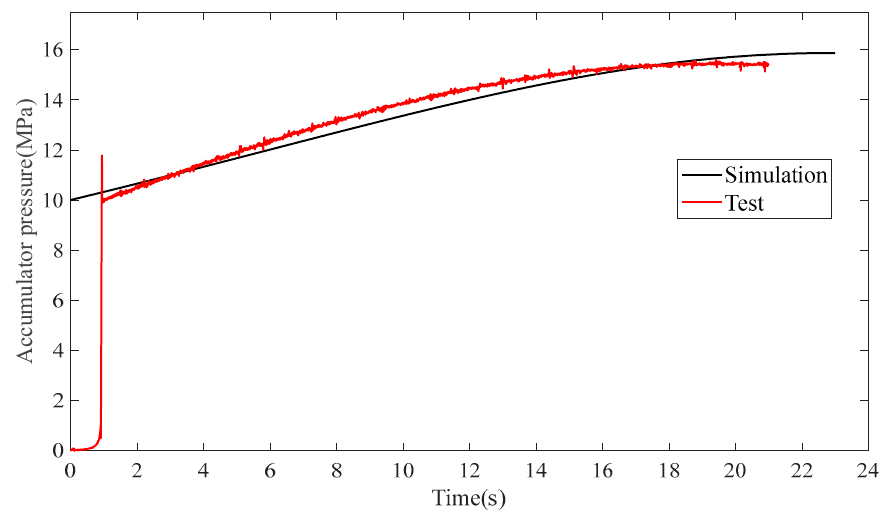
Figure 3. The variation curve of accumulator pressure .